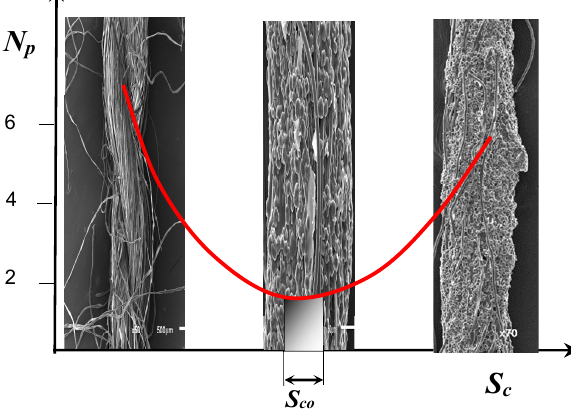
Figure 1. Effect of size pick-up on the number of breakages, with highlighted area of optimal size pick-up; Np—number of breakages of warp threads per machine and per hour, Sc—size pick-up, Sco—optimum size pick-up (%).